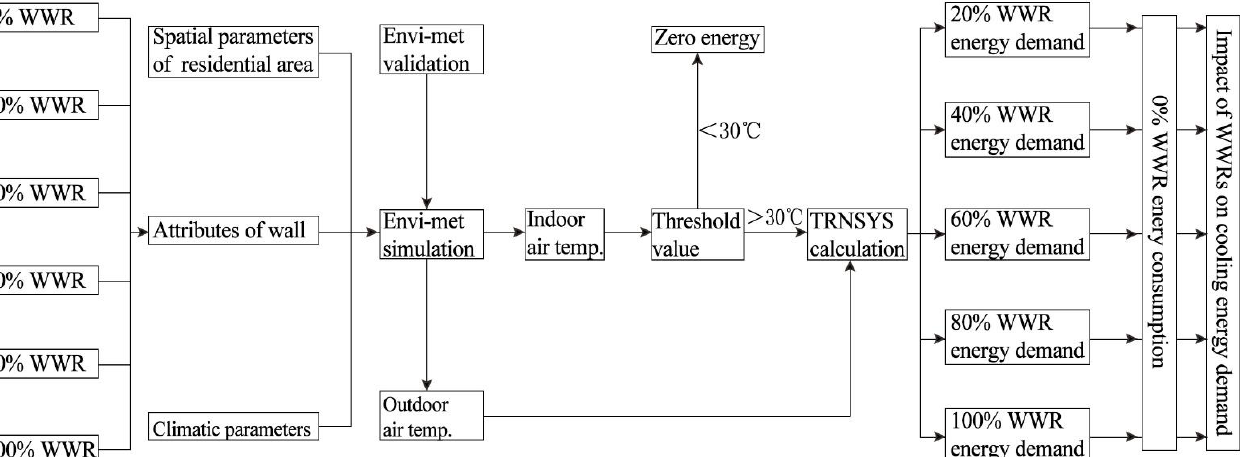
Figure 4. The daily variations of the air temperature, humidity, and wind speed.